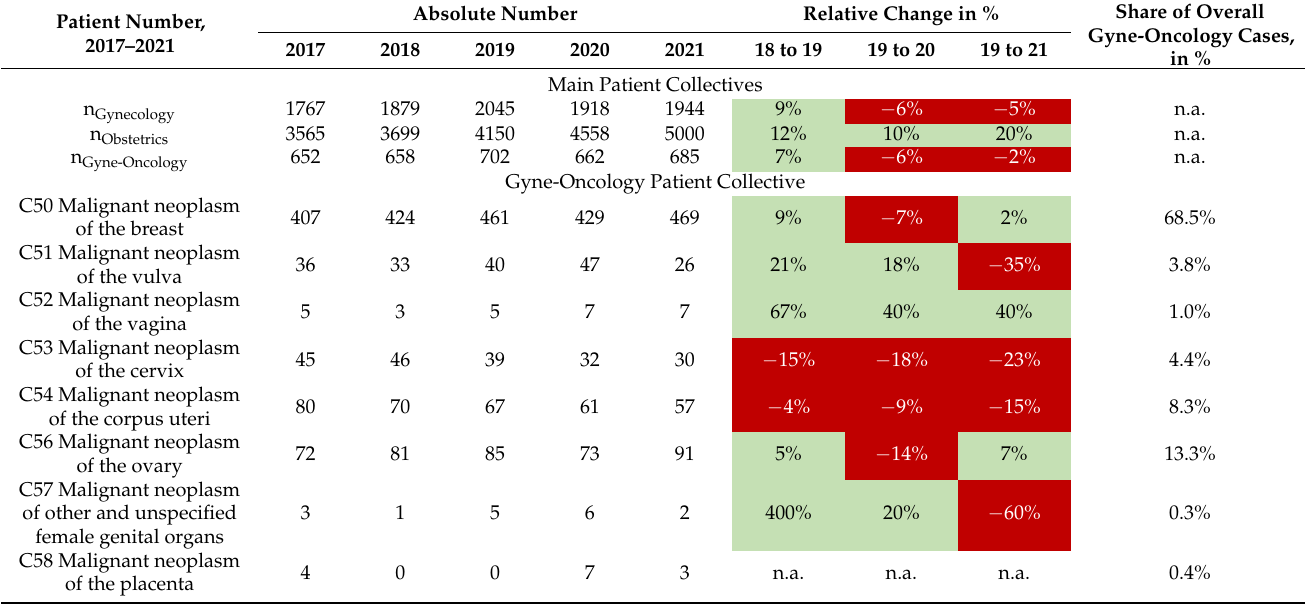
Table 1. Absolute and relative development of patient number of gynecology, obstetrics, and gyne- oncology patient